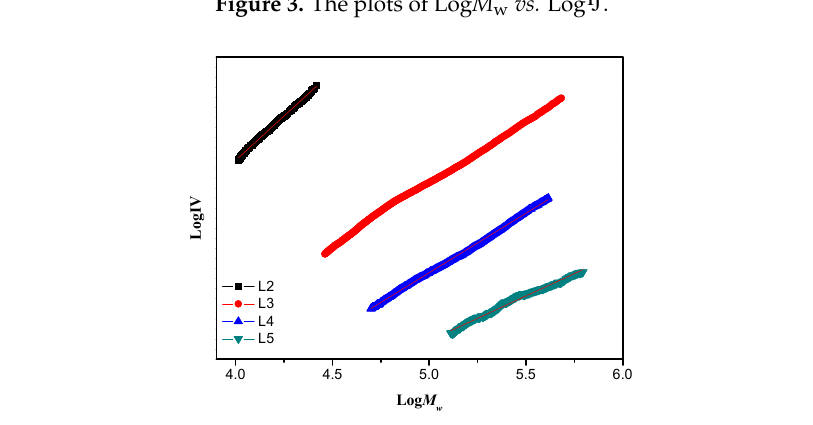
Figure 3. The plots of Log M w vs. Log ŋ .